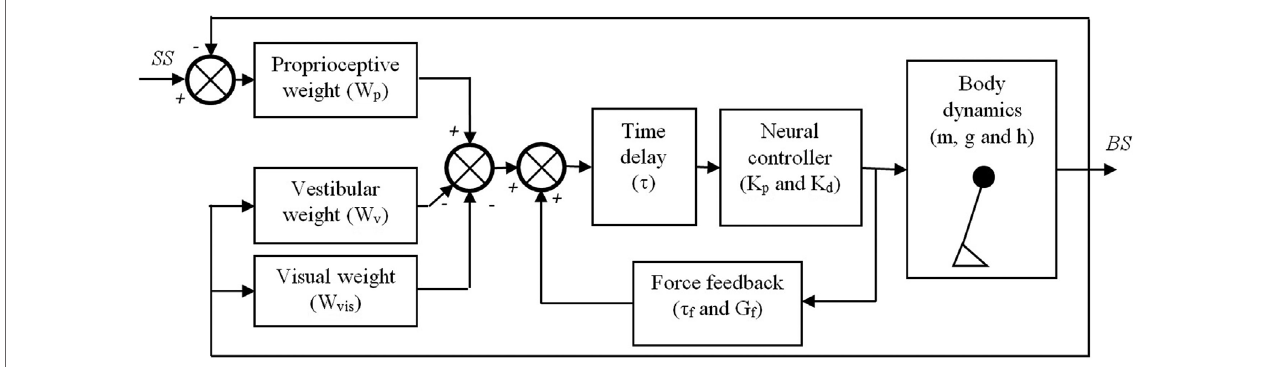
FigUre 1 | Balance control model that was used in this study. The body is represented by a single inverted pendulum of which the dynamics depend on its (point) mass ( m ), the height ( h ) of this mass above the ankle joints, and the gravitational constant ( g ). The body sway (BS) is sensed by three sensory systems, i.e., the proprioceptive system, the vestibular system, and the visual system. It is assumed that the contribution of each system to the sensory feedback signal depends on its reliability and is given by their weights, W p , W v , and W vis , respectively. The sensed BS is fed into a neural controller with a time delay ( τ ). The neural controller is assumed to be a proportional-derivative (PD) controller represented by a stiffness ( K p ) and damping ( K d ), which generates the torques needed to maintain an upright posture of the inverted pendulum. Finally, a positive force feedback loop of which the dynamics are given by a force feedback gain ( G f ) and a force feedback time constant ( τ f ) is assumed to assist in the detection of the BS, primarily on the lower